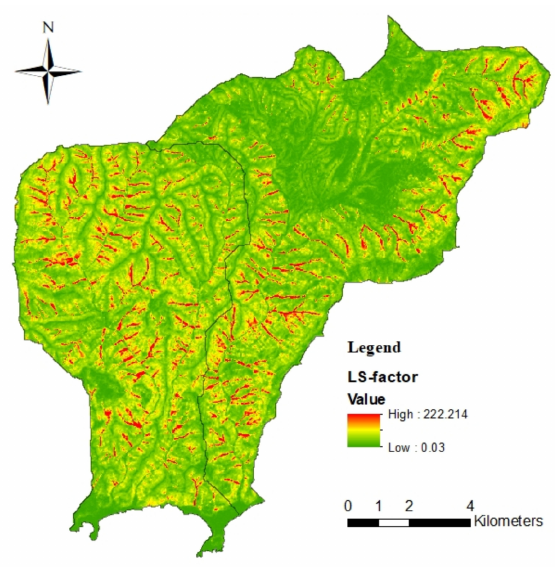
Figure 8. LS-factor